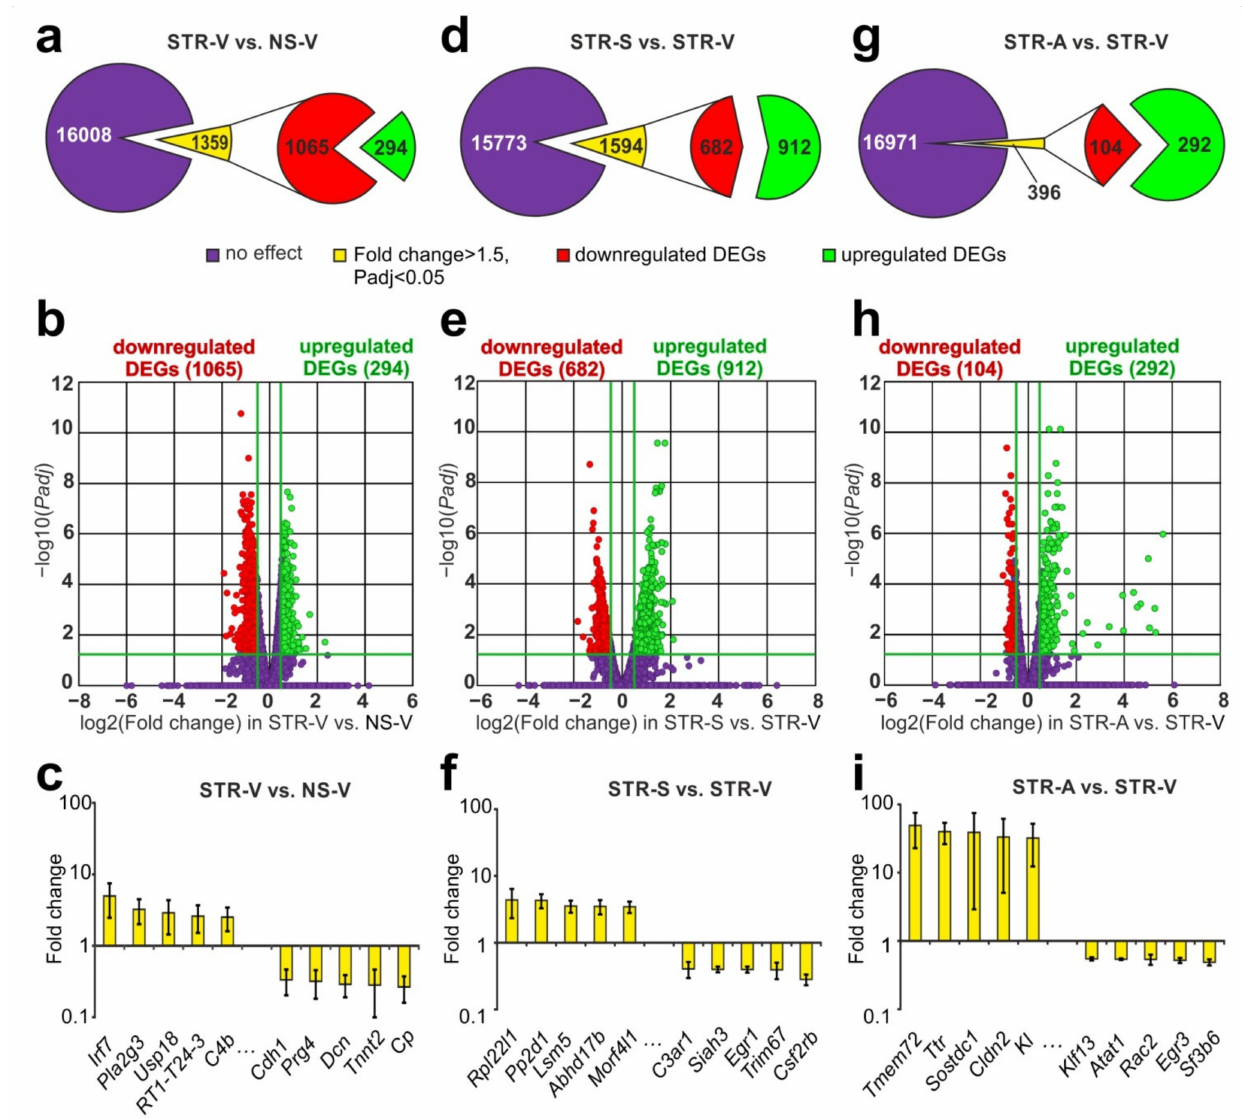
Figure 2. RNA-Seq analysis of the effect of ARS, and Semax or ACTH(6–9)PGP treatment in combination with ARS on the hippocampal transcriptome. ( a , d , g ) RNA-Seq results presented are for STR-V vs. NS-V ( a ), STR-S vs. STR-V ( d ), and STR-A vs. STR-V ( g ). The numbers in the diagram sectors indicate the number of DEGs. The cutoff for gene expression changes was a 1.50-fold change. Only those genes with p -values adjusted using the Benjamini–Hochberg procedure ( Padj ) < 0.05 were selected for analysis. ( b , e , h ) Volcano plots illustrate the differences in mRNA expression between the STR-V and NS-V groups ( b ), STR-S and STR-V groups ( e ), and the STR-A and STR-V groups ( h ). Up- and downregulated DEGs are represented as green and red dots, respectively (fold change > 1.50; Padj < 0.05). Genes that were not differentially expressed are represented as dark purple dots (fold change ≤ 1.50; Padj ≥ 0.05). ( c , f , i ) The top 10 genes that exhibited the greatest fold change in expression in STR-V vs. NS-V ( c ), STR-S vs. STR-V ( f ), and STR-A vs. STR-V ( i ). The data are presented as the mean ± standard error of the